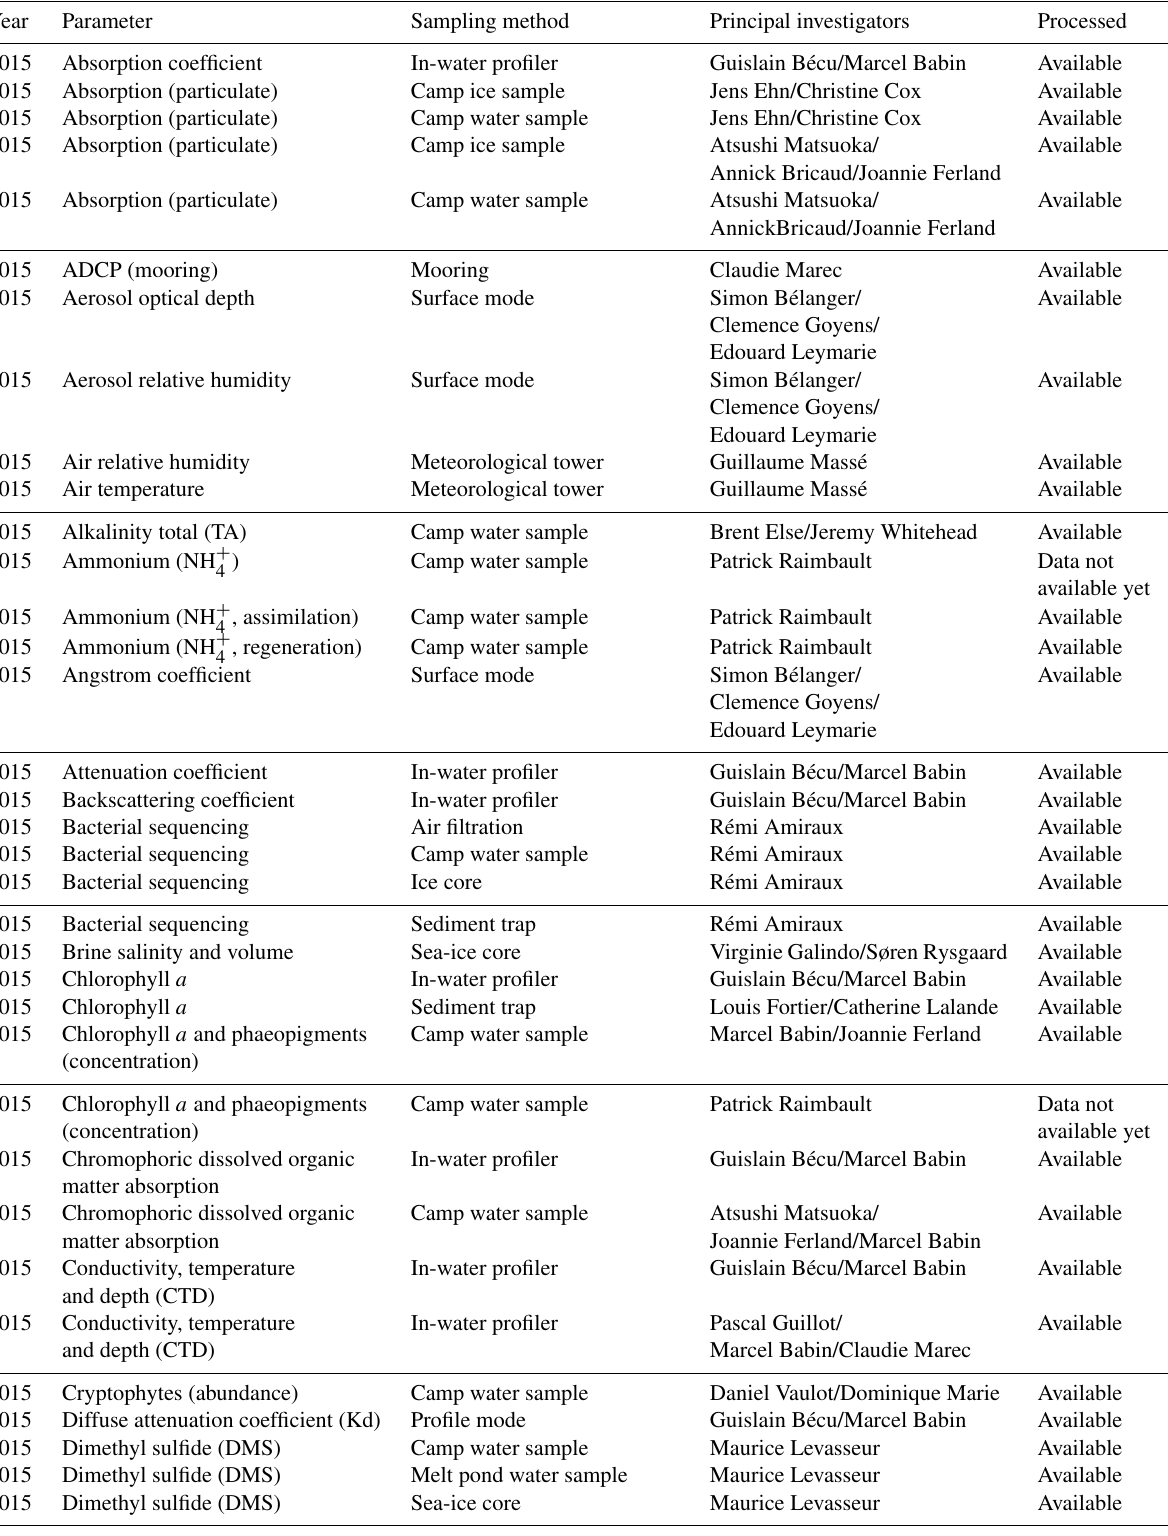
Table 2. Parameters measured during the Green Edge ice camp surveys. Parameters are ordered by alphabetical order and sampling